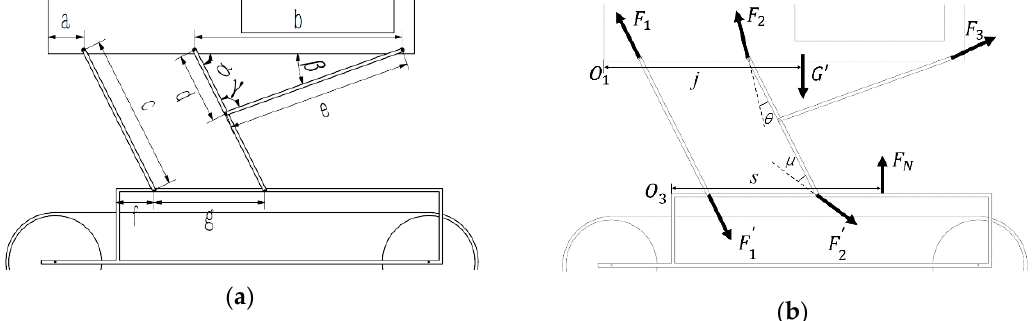
Figure 5. ( a ) Simplified model of robot frames with dimensions. ( b ) central body (origin is O 1 ) and crawler (origin is O 3 ) force distribution, G (cid:48) is the weight of central body, F N is the reaction force of F (cid:48) and F (cid:48) 2